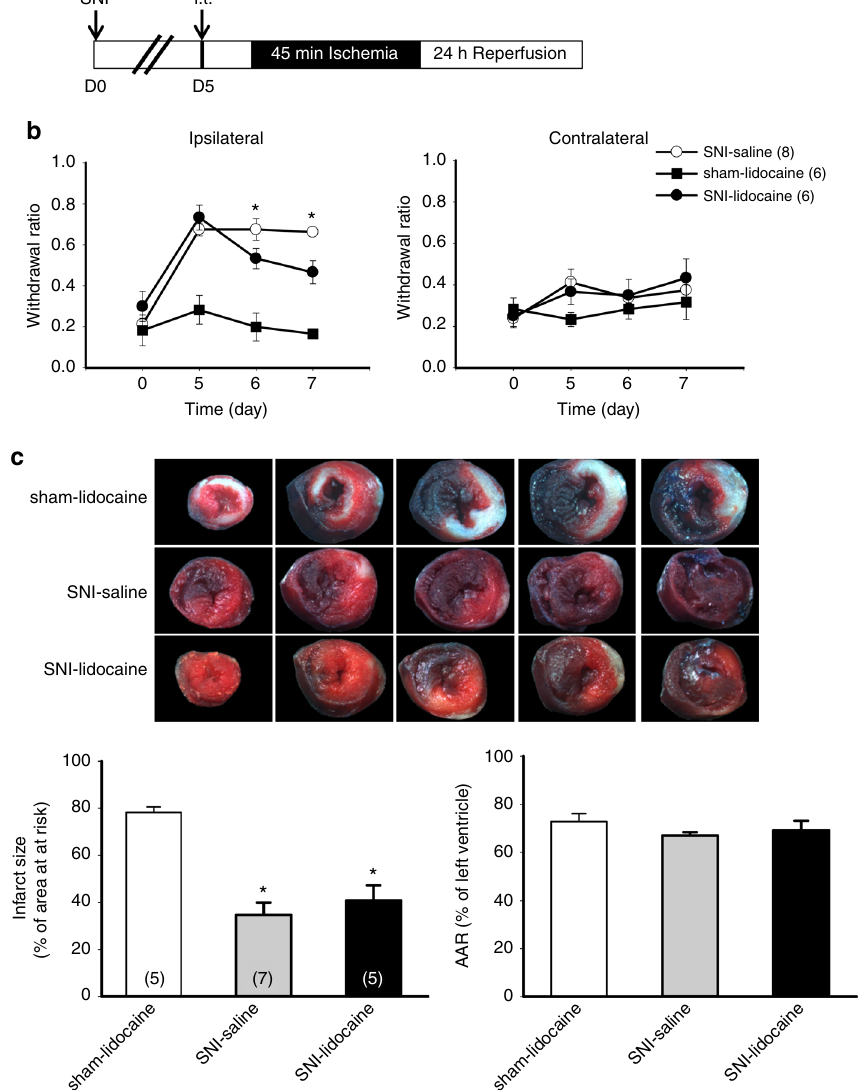
Fig. 2 Intrathecal injection of lidocaine reduces mechanical hyperalgesia but not SNI-induced cardioprotection. a Schematic of experimental design showing the timeline for SNI surgery (D0), intrathecal infusion (i.t.) of lidocaine (15 mg/kg, in 4 μ L saline) (D5), and myocardial IR surgery (D7). b Mechanical responses of hind paws in animals received saline or lidocaine infusion at the contralateral side and ipsilateral side. Mechanical responses of hindpaw were measured at day 0 (D0) before SNI surgery, D5 before lidocaine/or saline infusion, D6 and D7 using von Frey fi lament test. * p < 0.05 vs. saline group. c Representative images of TTC staining in heart cross-sections. Quanti fi cation results of infarct size and AAR in cardiac sections from saline and lidocaine- infused animals. SNI-induced cardioprotection was not affected even though pain response was reduced. * p < 0.05 vs. sham-lidocaine group. Error bars indicate SEM. Statistical signi fi cance was determined by two-way RM ANOVA ( b ) or Student ’ s t- test ( c